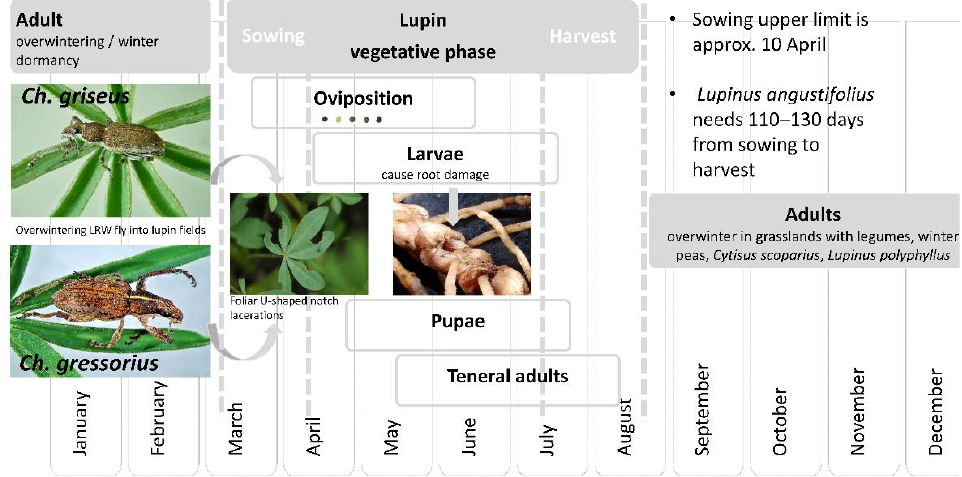
Figure 5. Generalized life cycle of lupin root weevils (LRWs) in Central Europe.